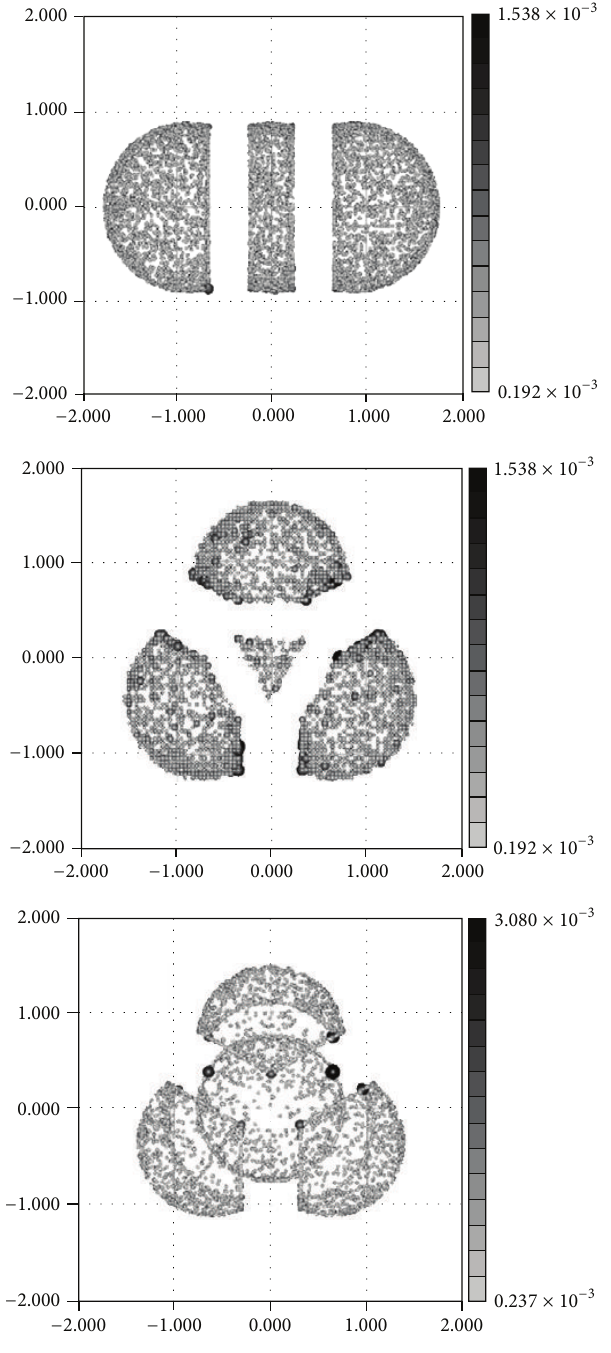
Figure 7: Contact ratio on the grain surface.